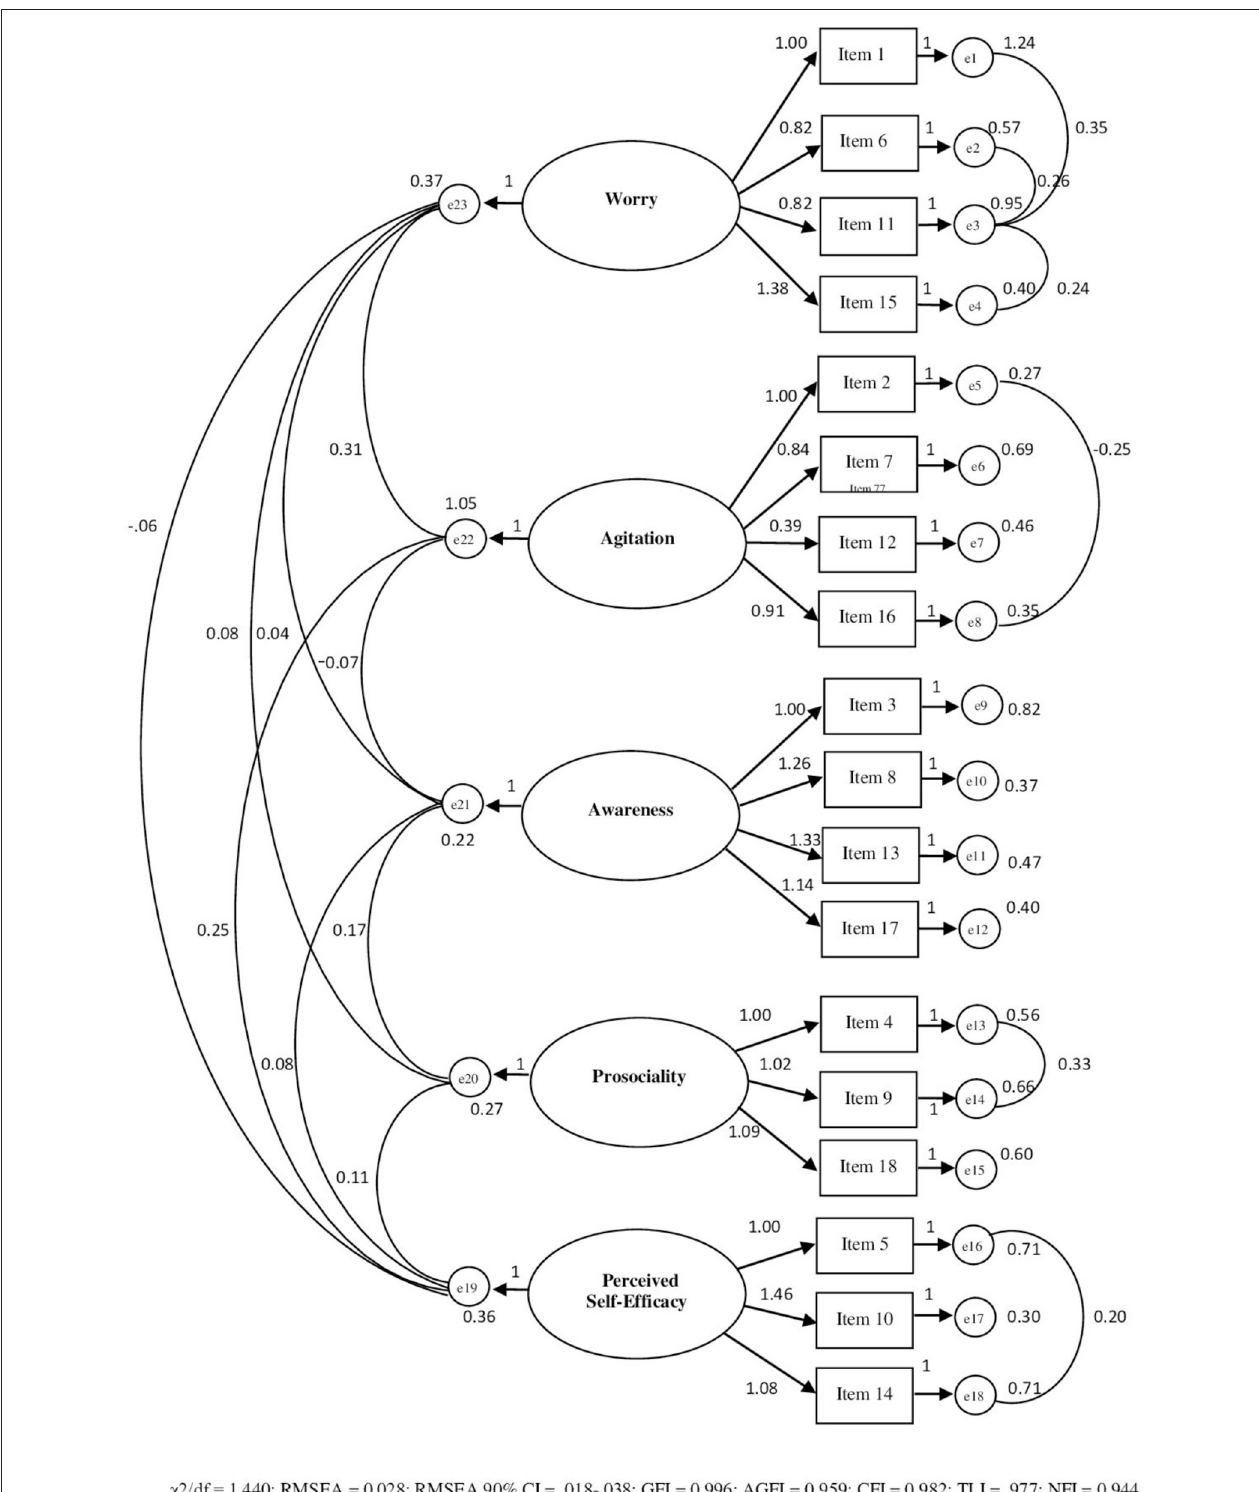
FIGURE 2 | Path diagram of the confirmatory analysis concerning ERPAS (18 items).